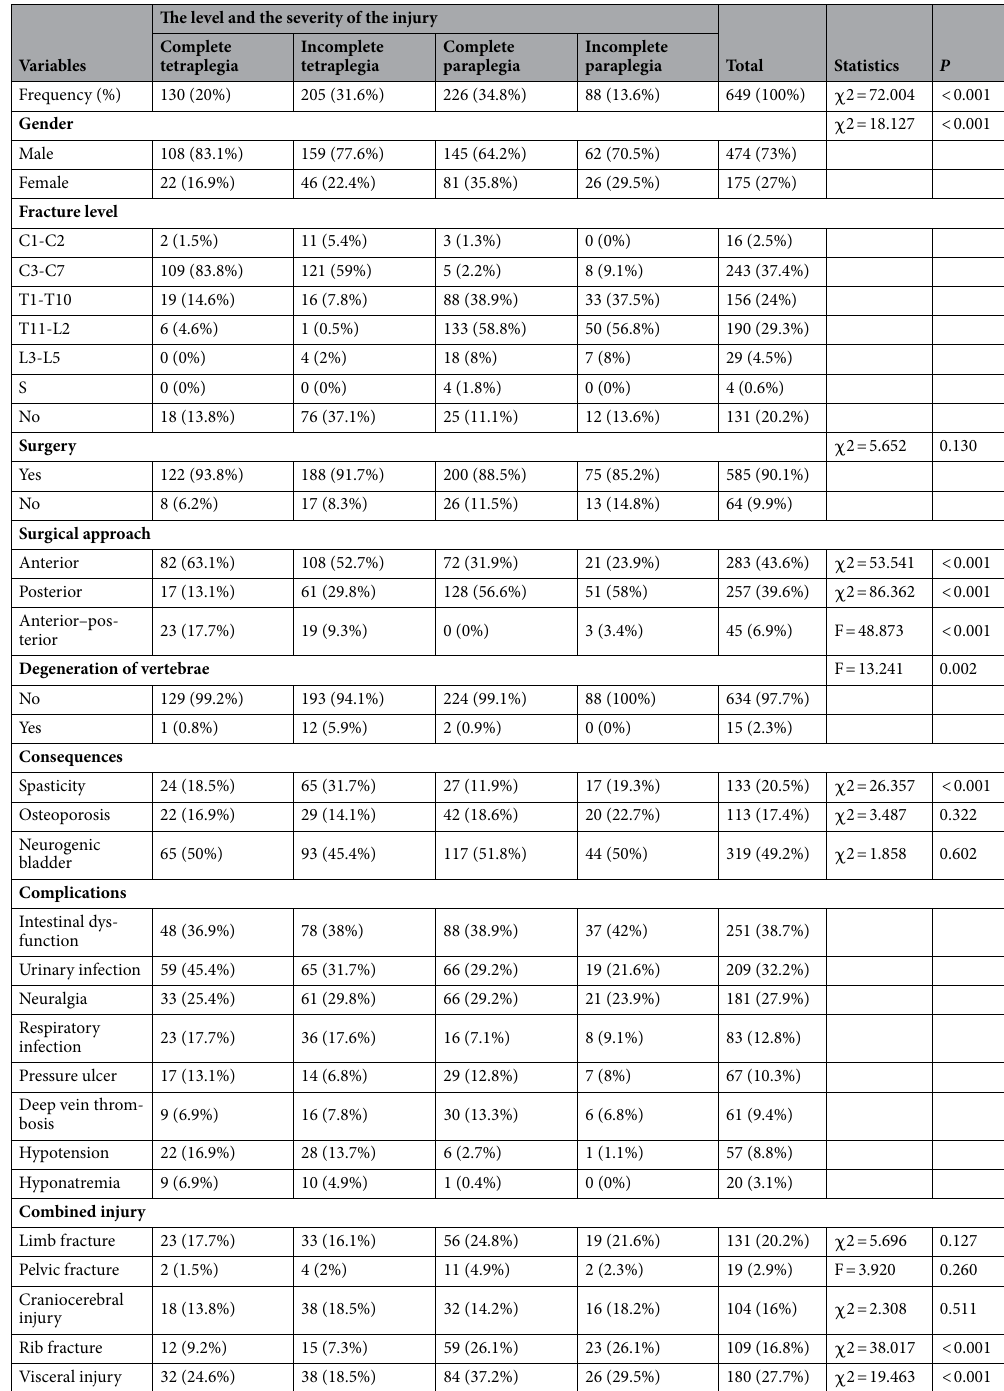
Table 2. Characteristics of 649 cases according to different level and the severity of the